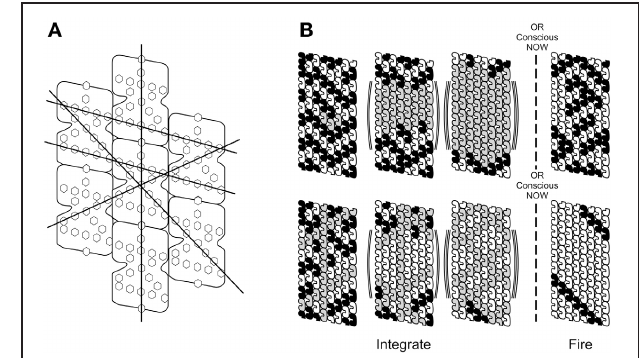
FIGURE 13 | (A) A microtubule, a cylindrical lattice of peanut-shaped tubulin proteins, with molecular model of enlarged single tubulin with C-termini tails (Craddock et al., 2012c). (B) Tubulin dimer, lower C terminus tail visible. Interior blowup shows aromatic rings clustered in a linear groove, and further blowup of ring structures. (C) Approximate locations of resonance rings suggesting trans-tubulin alignments (see Figure 14A ).